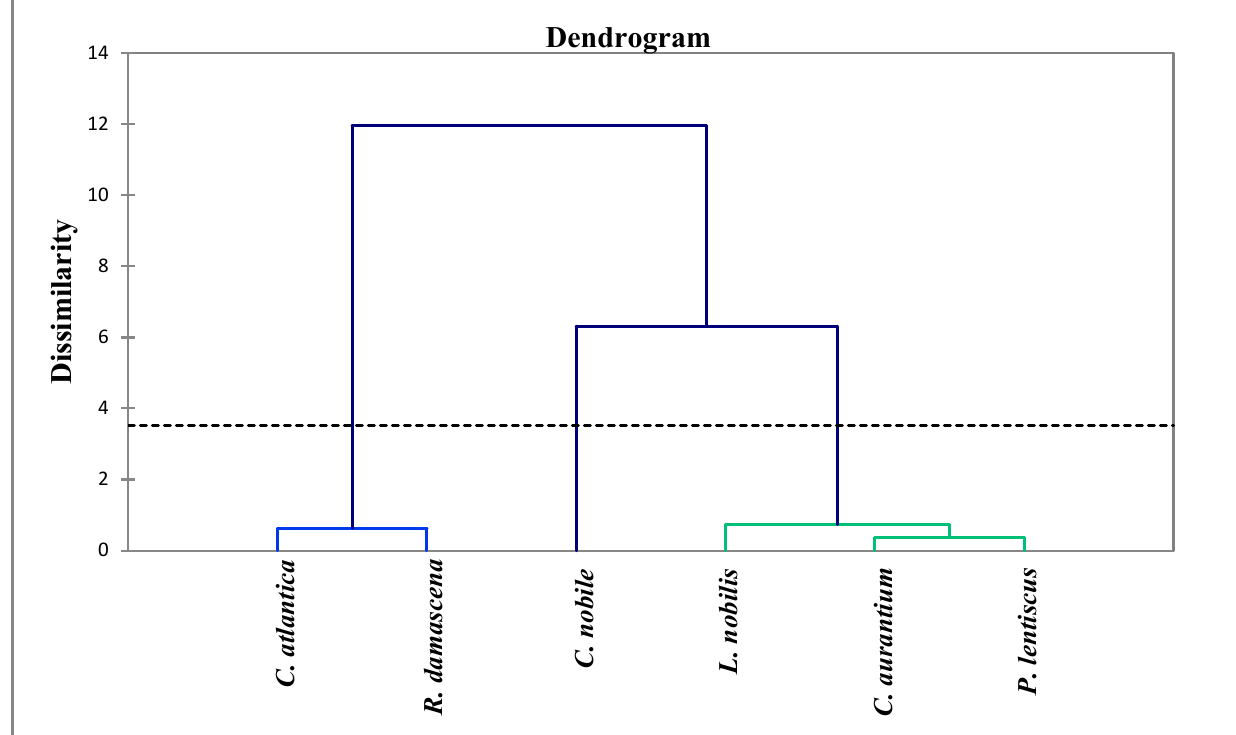
Figure 3. Phylogenetic tree of EOs of the plants studied.